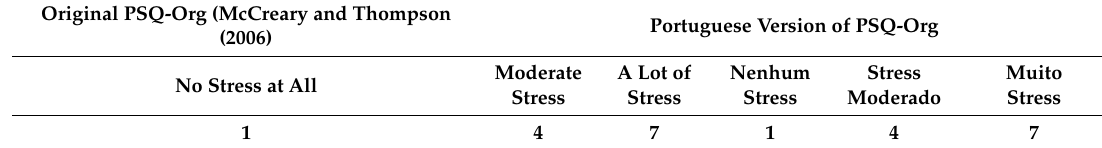
Table 1. Organizational police stress questionnaire (PSQ-Org) original and Portuguese versions. Original PSQ-Org (McCreary and Thompson